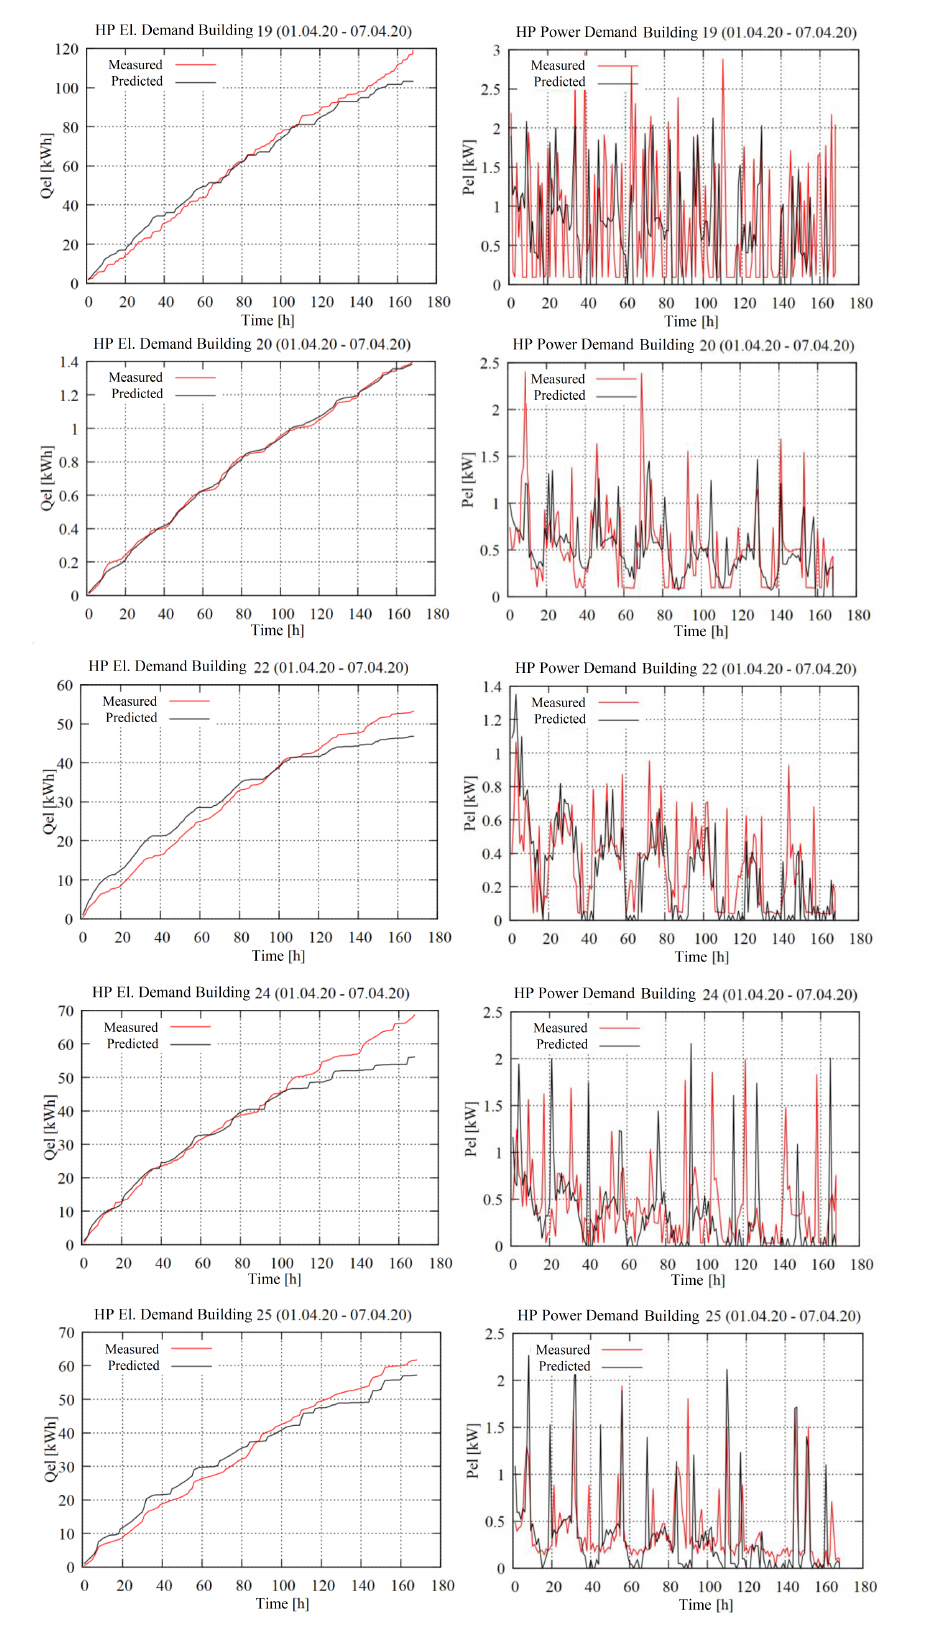
Figure A2. Building model calibration results (Building